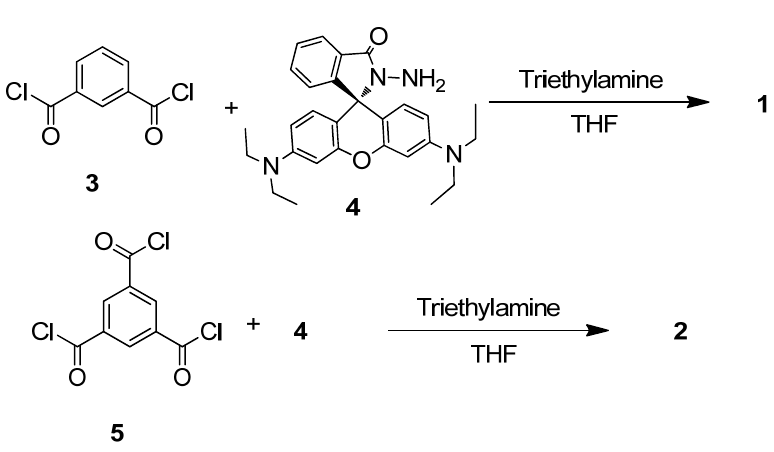
Scheme 1. Synthesis of chemosensors 1 and 2 .